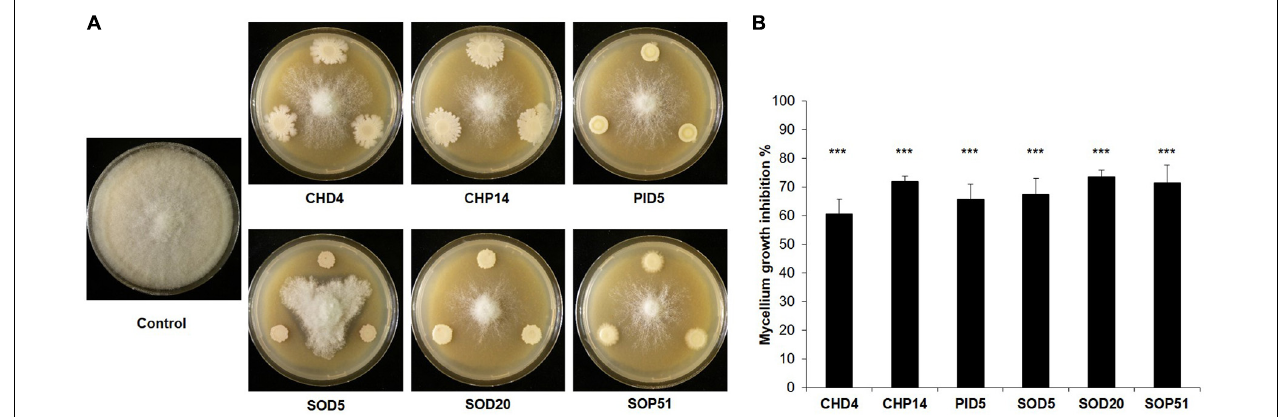
FIGURE 3 | Inhibition of mycelial growth of Botrytis cinerea. Representative pictures of dual assays with Botrytis cinerea non-exposed to the bacteria (Control) or exposed to six bacterial strains isolated from the grapevine microbiome are shown in (A) . Pictures were taken 6 days after B. cinerea inoculation. The percentage of B. cinerea mycelium inhibition induced by each strain compared to the non-exposed control that represents 100% is shown in (B) . Bars represent average inhibitions of five replicates with standard deviation. The percentage of inhibition was determined 6 days after B. cinerea inoculation. Asterisks represent statistically significant differences in comparison to the control ( t -test; p < 0.001). The experiment was repeated twice with similar